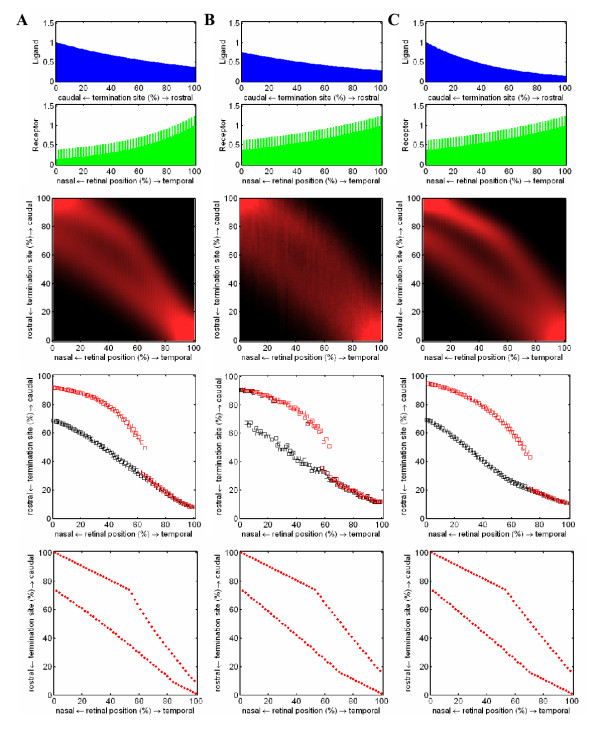
Manipulations with chemical labels, which lead to shifts in the bifurcation point A. The endogenous receptor gradient is made steeper compared to Figure 5B. The single-valued part of the map expands caudally. B. Density of ligand is reduced by 25%. Similar expansion of the single-valued part of the map is evident. C. The ligand gradient is made steeper. This is to reproduce the possible effect of ligand dimerization. The bifurcation point is moved slightly rostrally, expanding the double-valued part of the map. In all three columns the vertical arrangement of panels is similar to Figure 5.